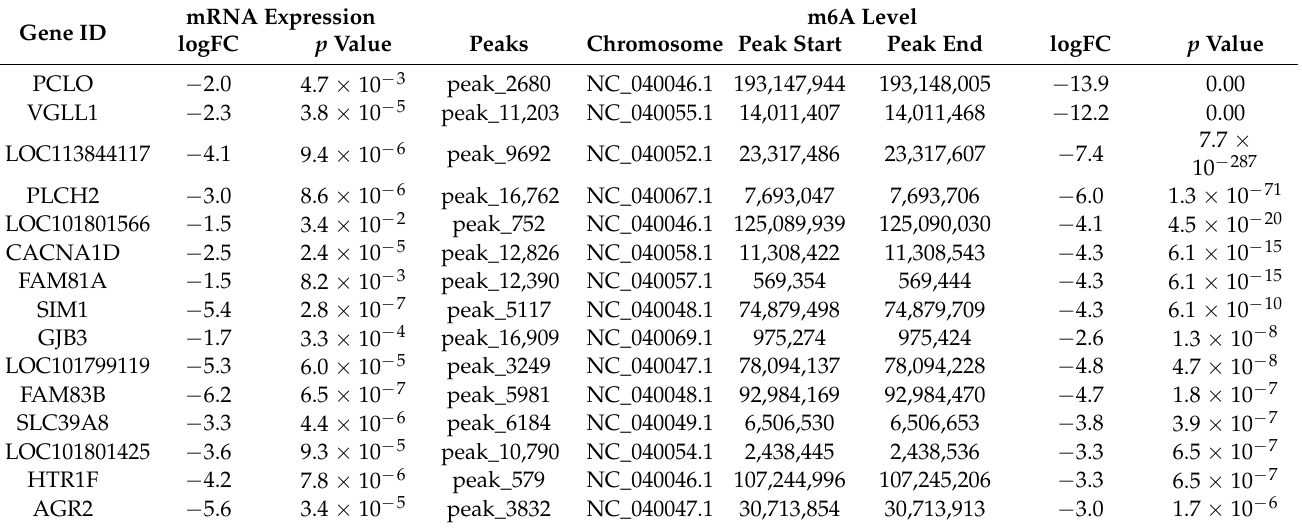
Table 6. Top 15 of hypo-down methylated genes that were significantly different between E19 and